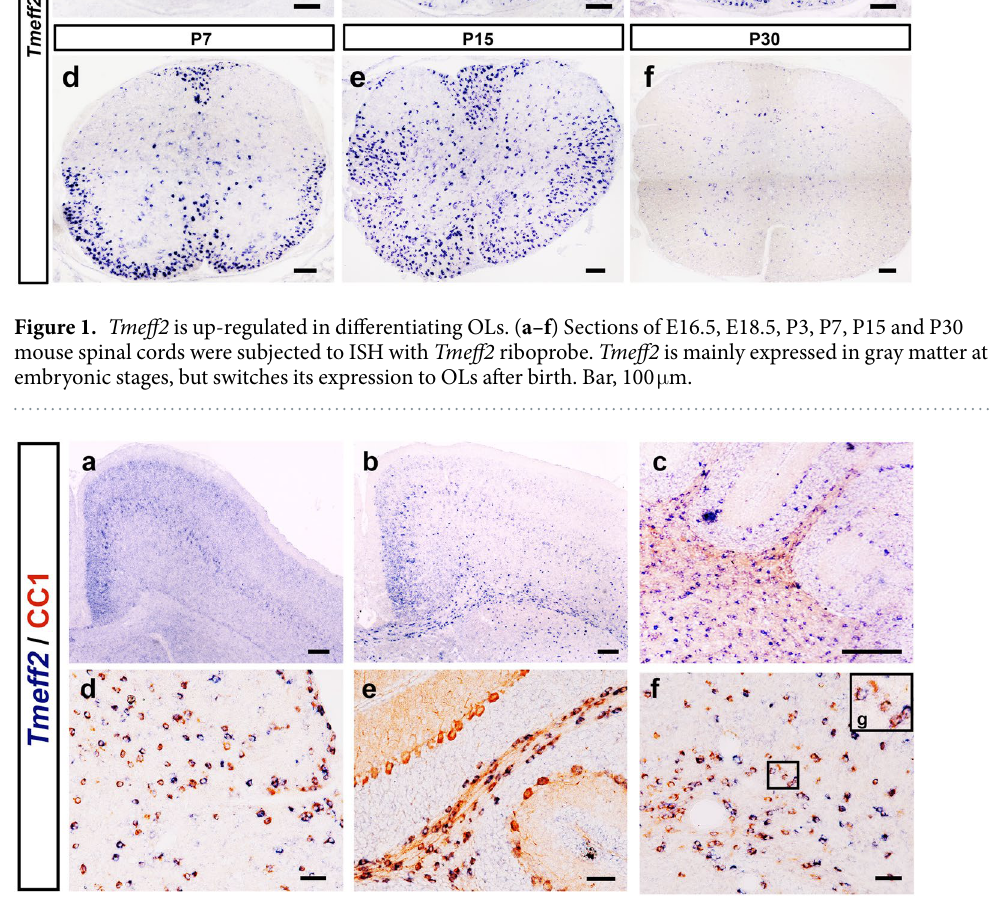
Figure 2. Tmeff2 -expressing cells are immunoreactive to CC1 in different regions of the CNS. ( a–c ) Tmeff2 expression was detected in cortex at P7 ( a ), corpus callosum ( b ) and white matter of cerebellum ( c ) at P15. Bar, 250 μ m. ( d–g ) Tmeff2 co-expresses with CC1 in spinal cords ( d ), cerebellum white matter ( e ) and corpus callosum ( f,g ) at P15. Bar, 50 μ